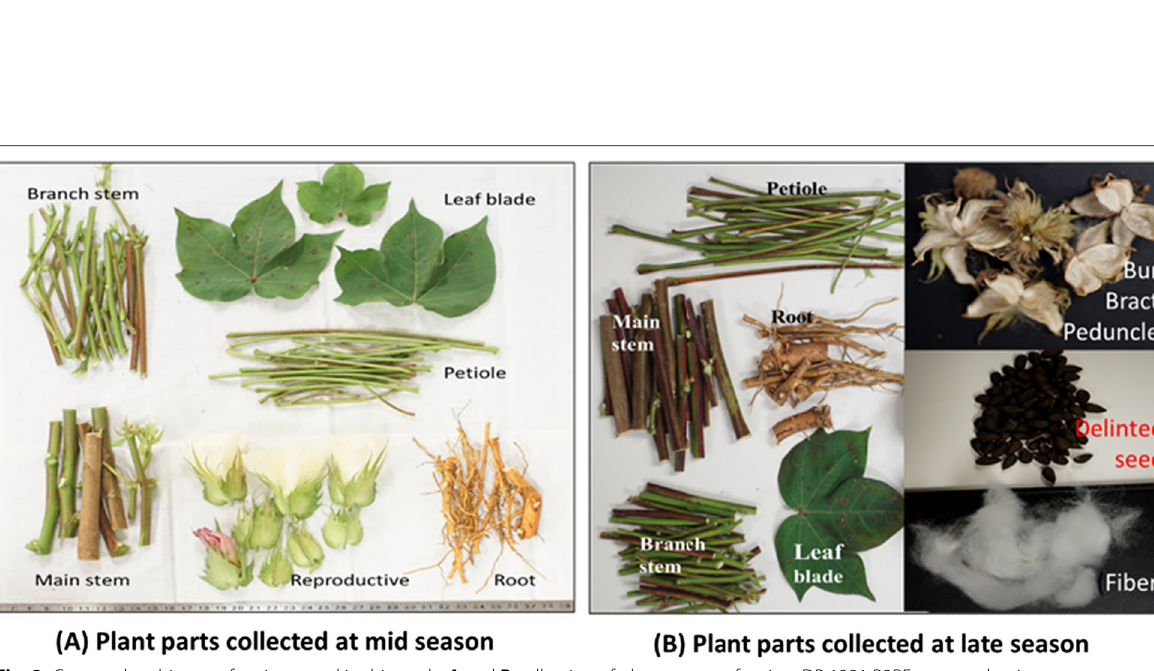
Fig. 2 Cotton plant biomass fractions used in this study. A and B collection of plant organs of variety DP 1321 B2RF, at reproductive stage (mid-season) and maturation stage (late season at pre-defoliation for harvesting), respectively. Bur, bract, and peduncle are not